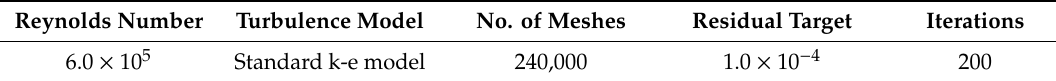
Figure 13. Schematic diagram of meshing. Table 5. The solver parameters.